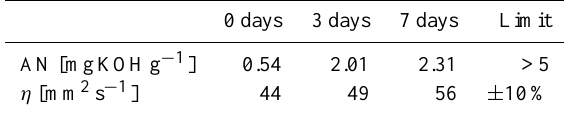
Table 5. Acid number (AN) and kinematic viscosity η for mineral hydraulic oil (Shell Tellus); artificially aged samples.